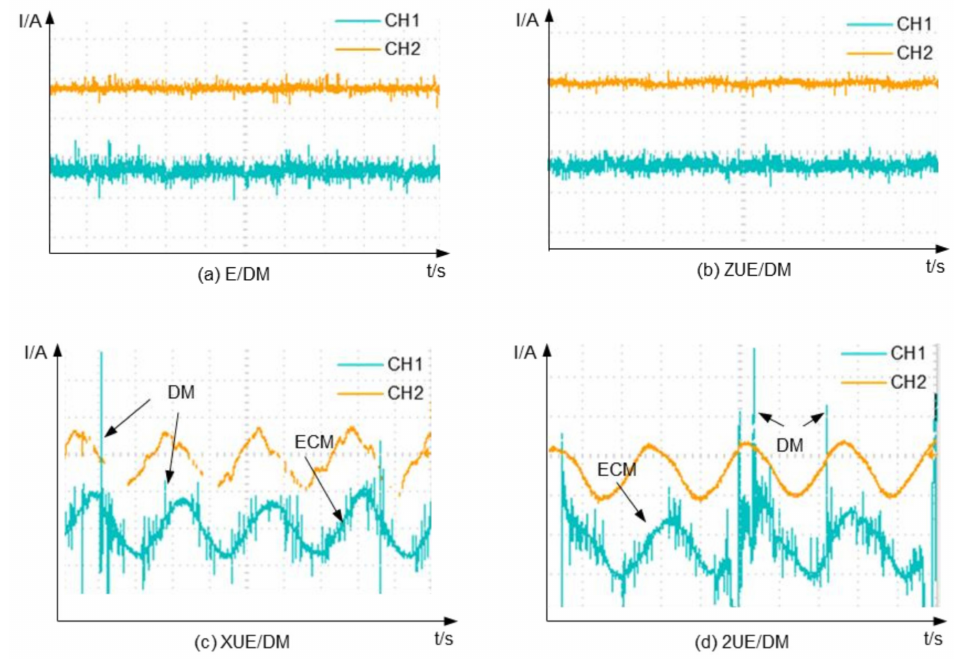
Figure 5. Comparison of current signals: ( a ) GE/DM; ( b ) ZUE/DM; ( c ) XUE/DM; ( d ) 2UE/DM.